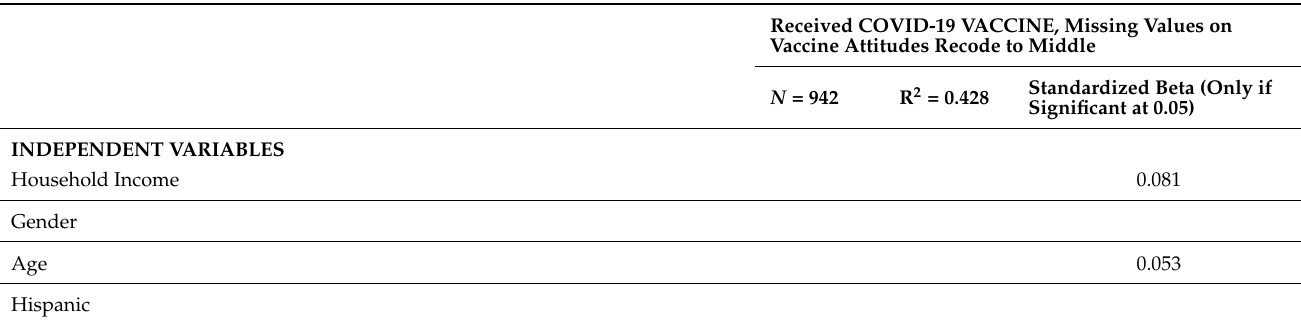
Table 5. Predicting COVID-19 Vaccine Received by Demographics, COVID-19 Specific Factors, and General Vaccine